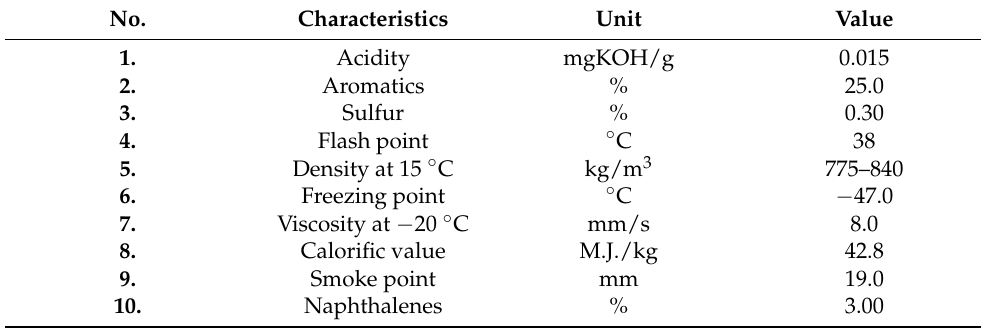
Table 3. Selected properties of Jet A-1 aviation